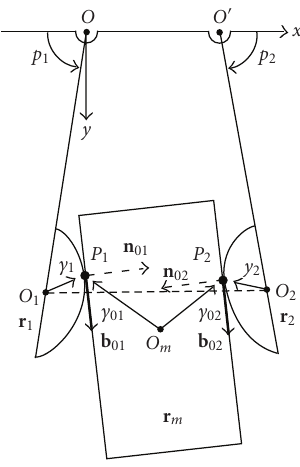
Figure 5: Precision prehension of a 2D object with parallel flat surfaces by a pair of single-DOF